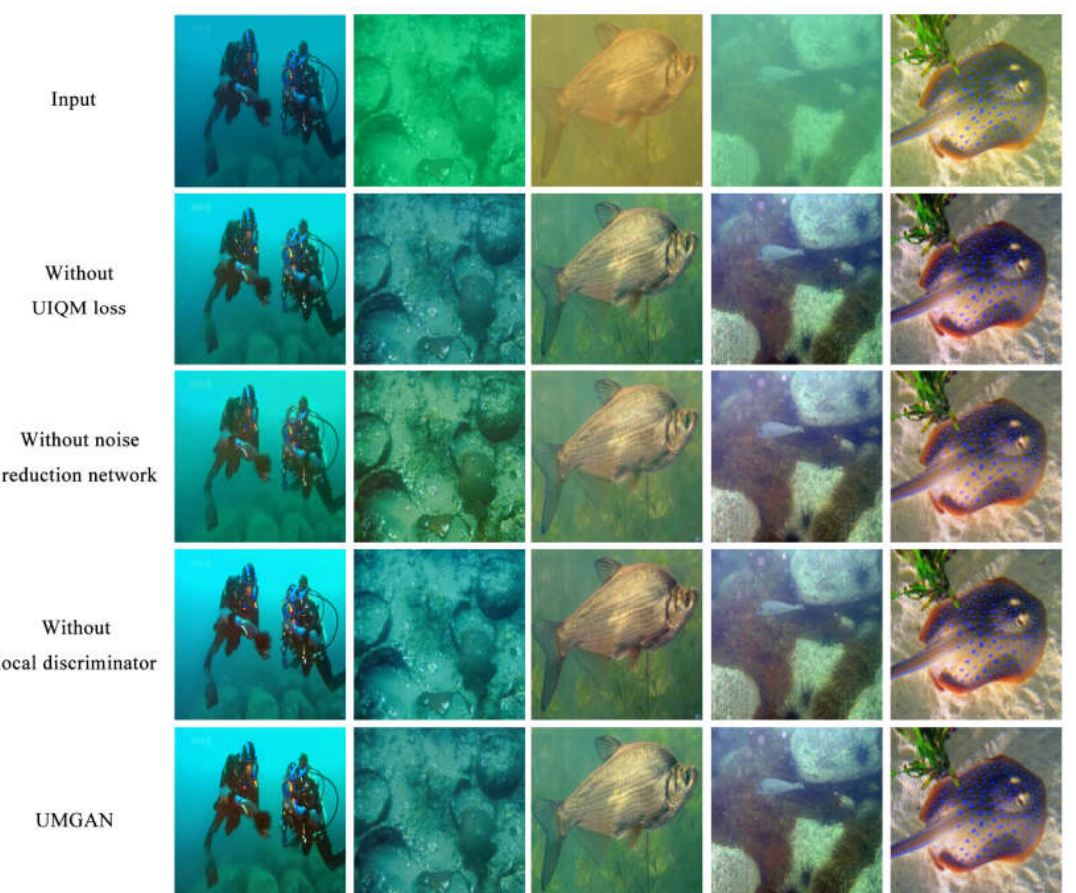
Figure 6. Visual comparison from the ablation study. Table 1. Quantitative evaluation of ablation experiments (best scores are bolded; the numbers in parentheses represent the percentage boost after adding the